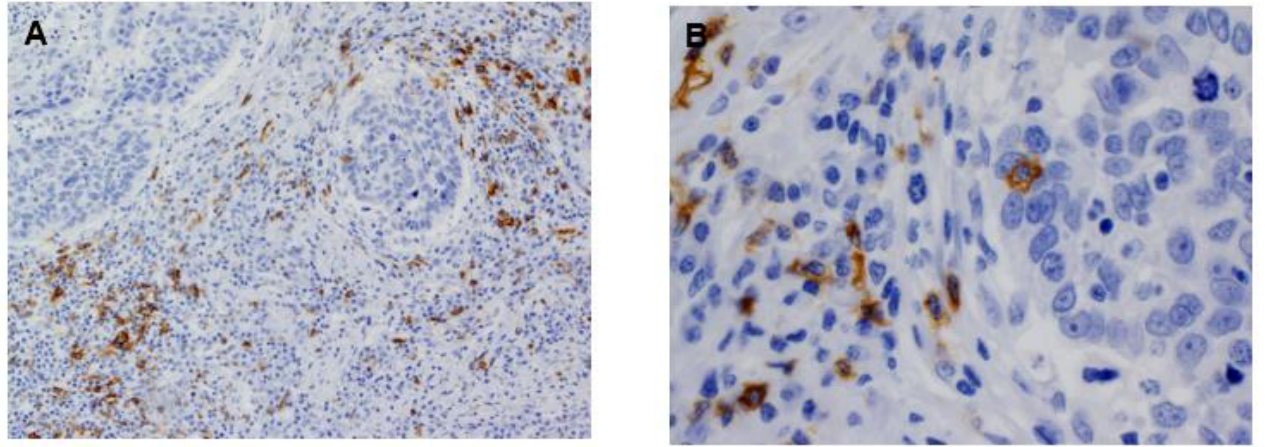
Figure 1. Immunohistochemical analysis of CD20 + B lymphocytes in oral squamous cell carcinoma (OSCC) tissue specimens. (Original magnification × 200 in panel ( A ), × 400 in panel ( B )).